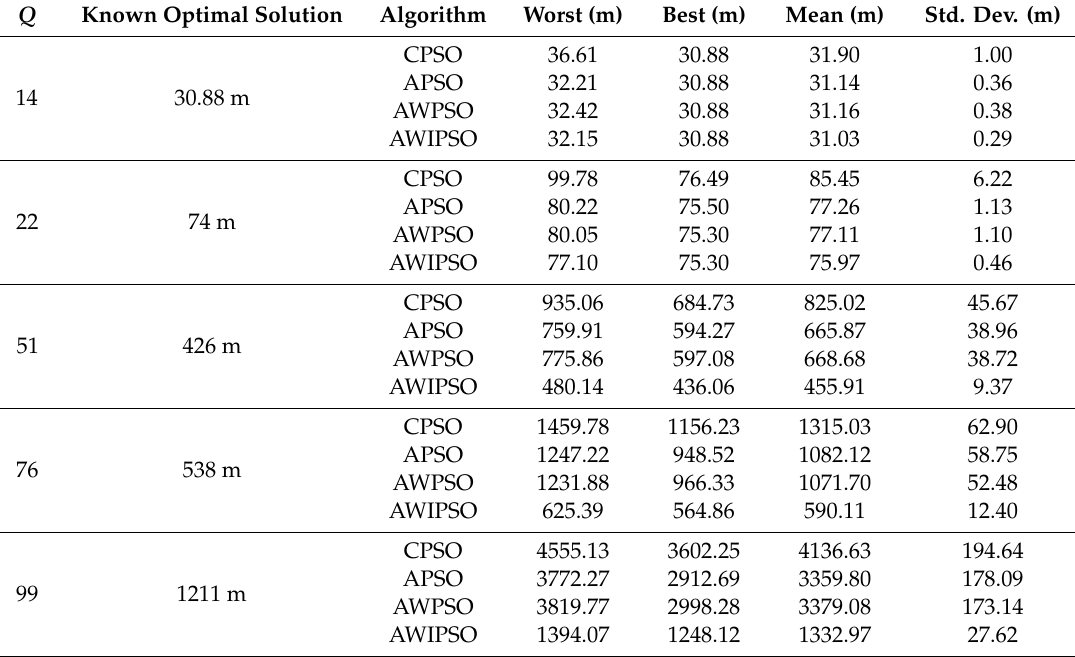
Table 2. Statistical results of optimal path distance in 100 runs with five numbers of planned